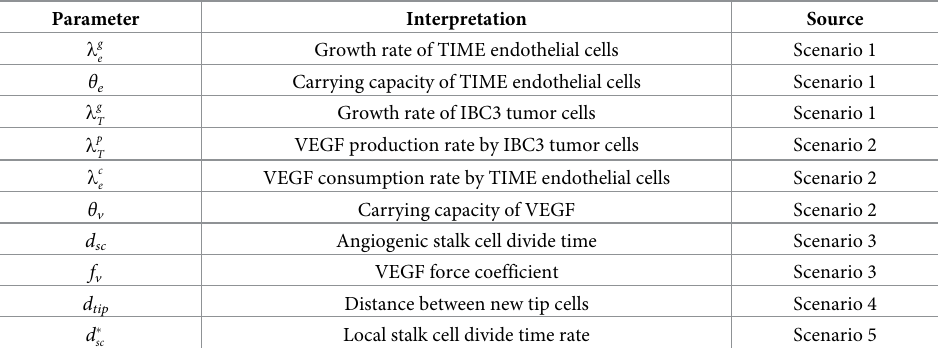
Table 1. Model parameters to be